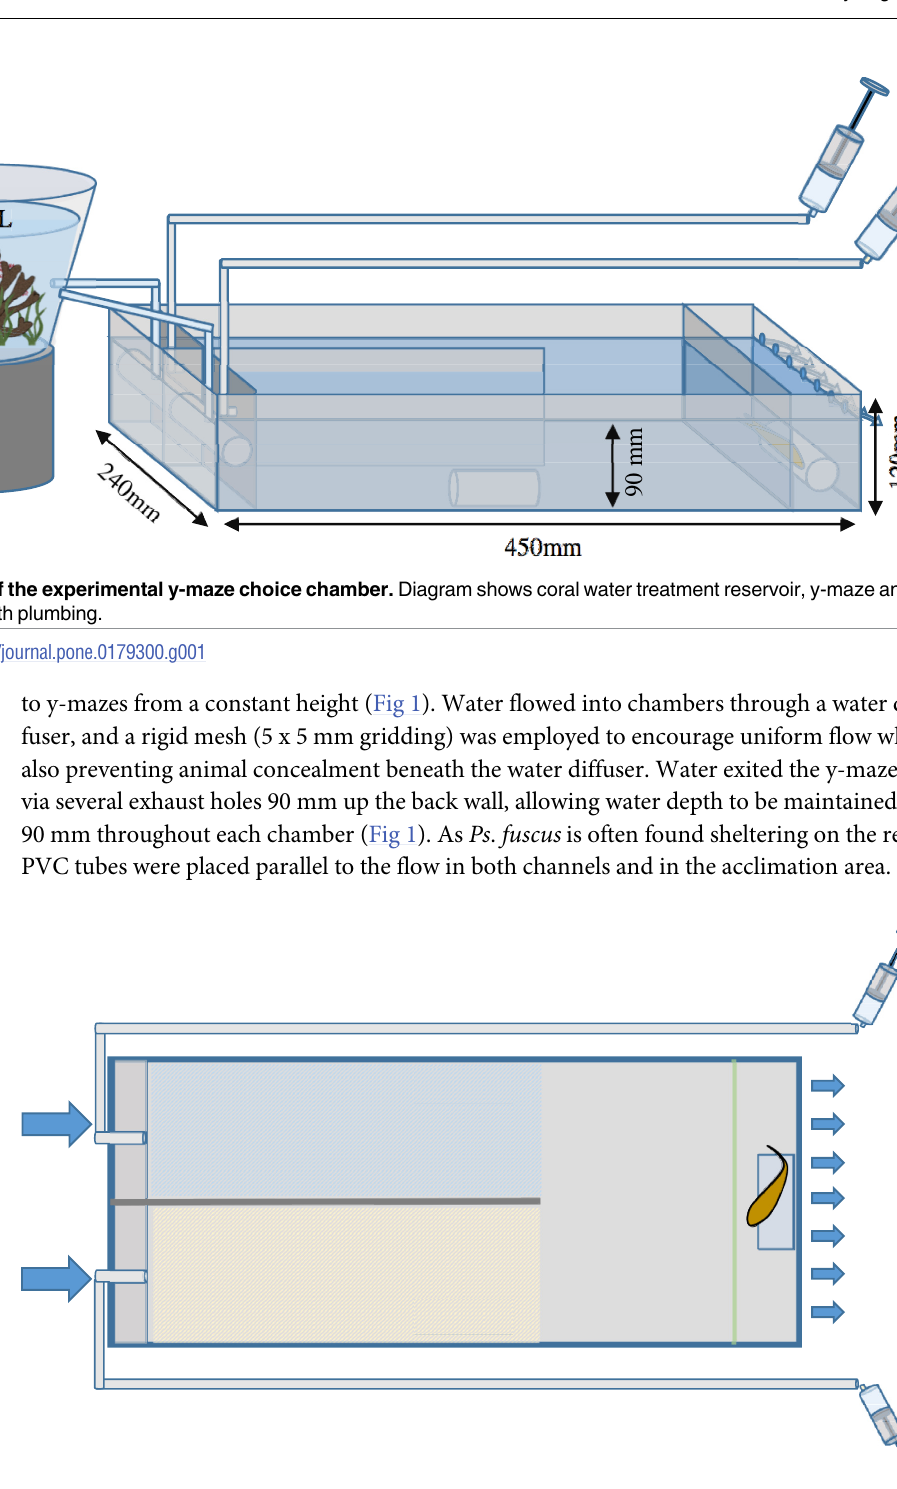
Fig 2. Top-down view of the experimental y-maze choice chamber (450 x 240 x 120 mm). Hatched areas (yellow/blue) indicate the two physically dividedchambers(each 270 x 120 x 120 mm). To the right of these is an area (180 x 240 x 120 mm) where the physical barrier (dark grey) is not present, within which a fish acclimation zone (60 x 240 x 120 mm) is created via installationof a rigid removable mesh guard (5 x 5 mm wire mesh) (green). Blue arrows indicate the entranceof water to the y-maze on the left from the water treatment reservoir, and its exit from the y-maze on the right. Syringes and tubes indicate the locationof cue injections into